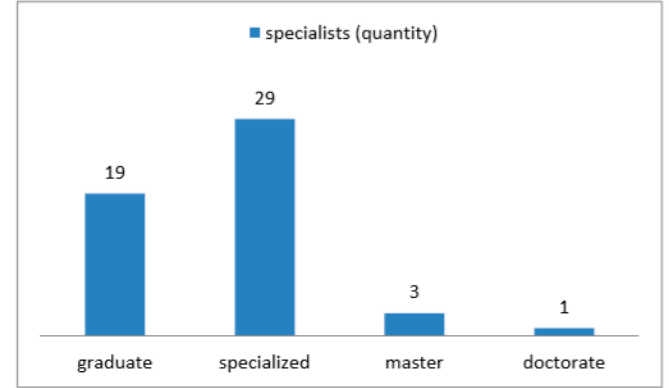
Figure 14. Quantitative distribution of the specialists by graduation level.